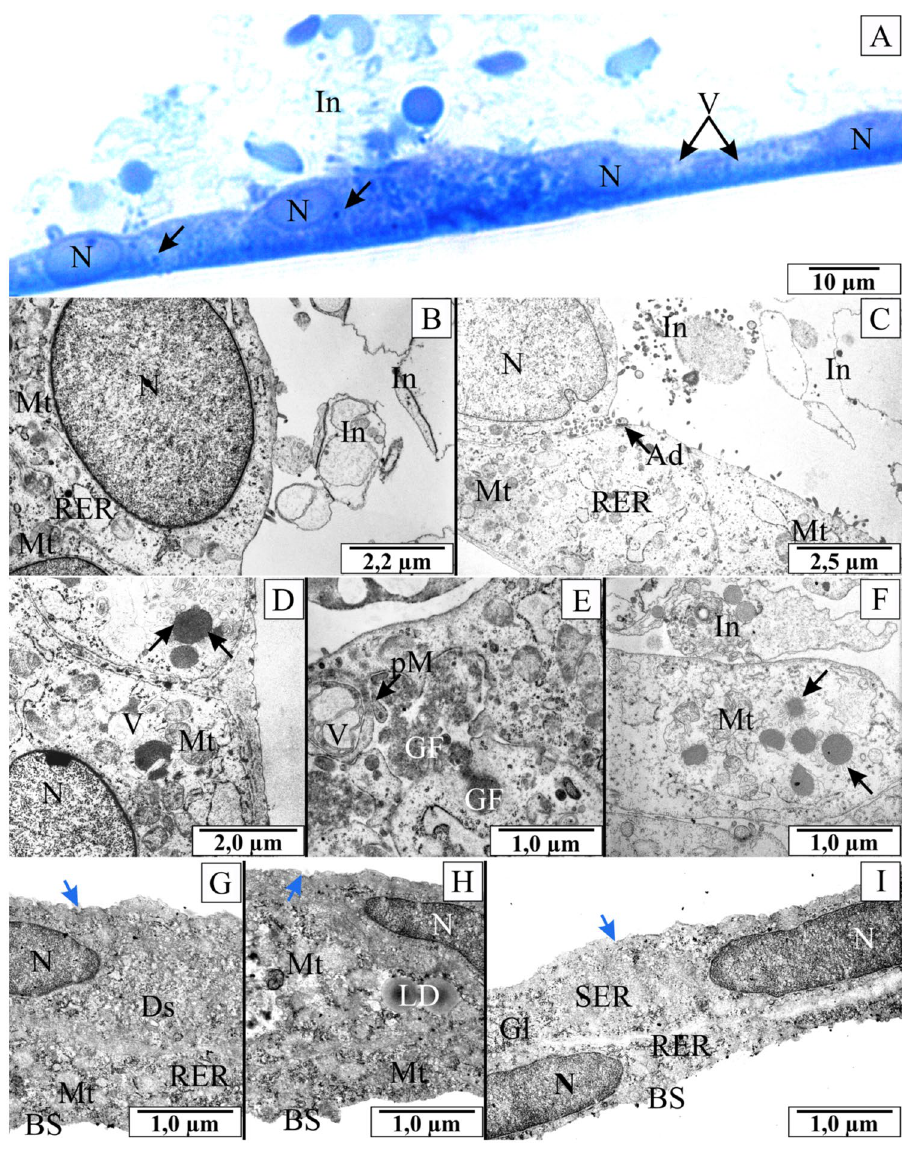
Figure 3. The histological and ultrastructural structure of NRK-52E cells cultured with B. microti . ( A ) semithin cross-section of NRK-52E cells stained with methylene blue. Arrows indicate granules inside the epithelial cells. ( B–F ) electronmicrographs of NRK-52E cells. In some cells, vacuolisation inside the cytoplasm was noted. The structure of the cytoplasm was heterogeneous. Large amounts of erythrocytes shadow with granules were visible above the cell free surfaces. ( G–I ) electronmicrographs of NRK-52E cells cultured with blood collected from Babesia -negative rat’s. Arrows in figure ( D , F ) indicate oval or round structures with high osmophilicity, surrounded by a ring of small elongated elements. Blue arrows in figures ( G,H , I ) endocytic membrane pits. Ad—arrow in figure ( C ) indicates adhesion between B. microti and renal plasmalemma, BS basal side of cells, Ds dictyosome, GF granular-fibrous material, Gl glycogen, In inoculum with B. microti , LD lipid droplets, Mt mitochondria, N nucleus, pM arrow in figure ( E ) indicates pyriform merozoite, RER rough endoplasmic reticulum, SER smooth endoplasmic reticulum, V